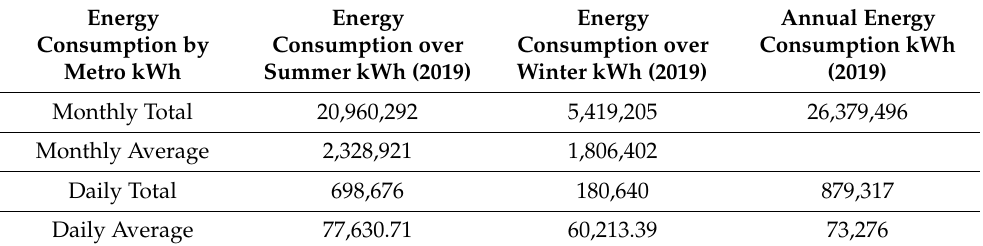
Table 1. Energy consumption by PNU metro during 2019 (kWh).